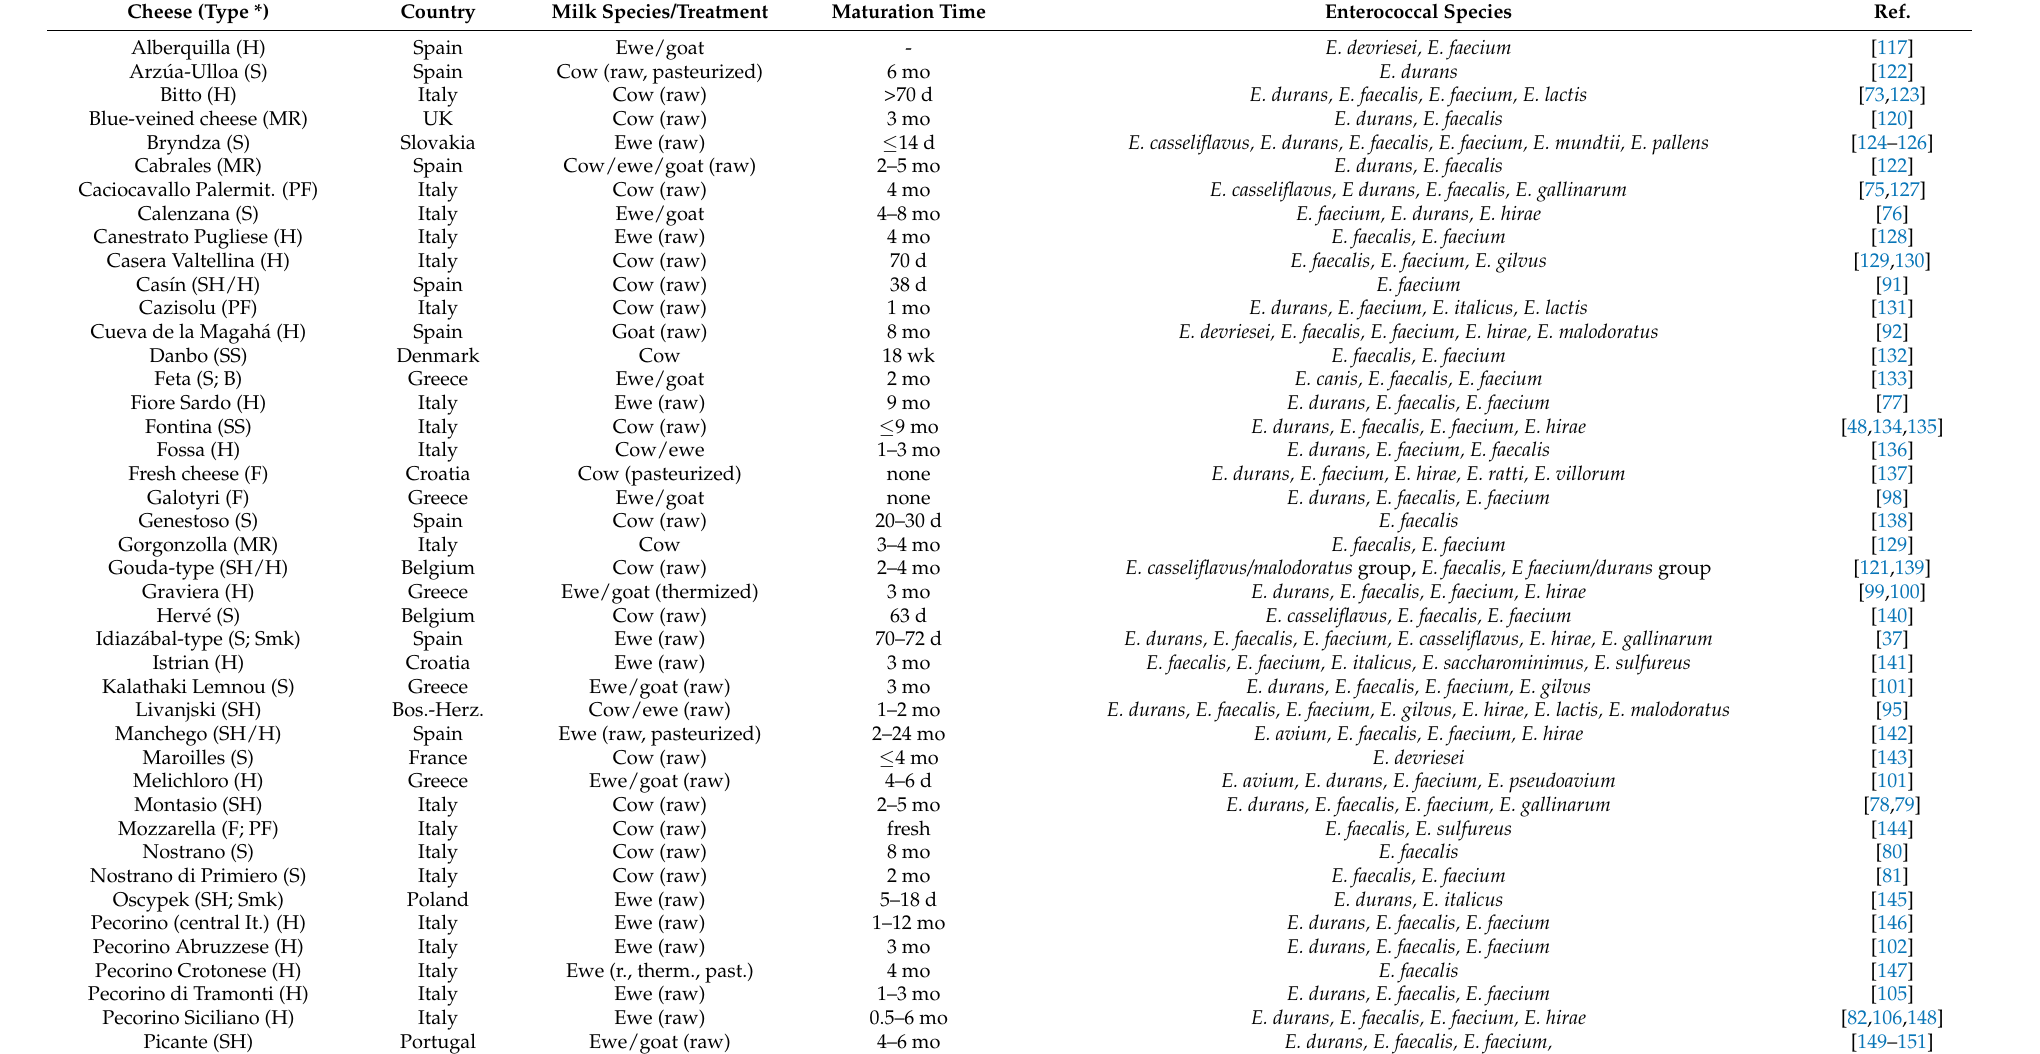
Table 1. Enterococcal species identified in European artisanal/traditional cheese